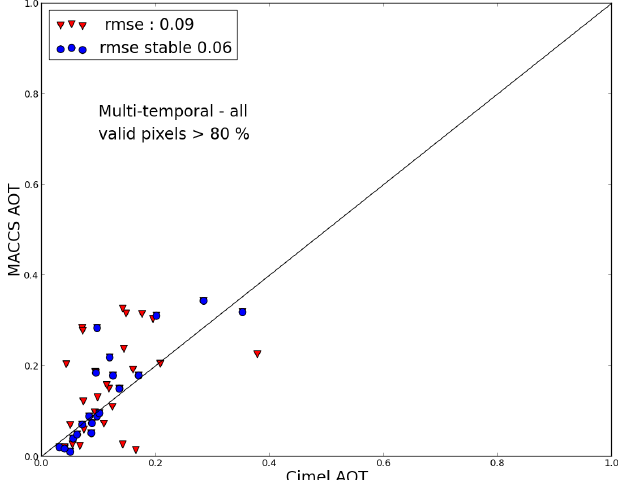
Figure 9. Validation of SPOT-4 (Take 5) AOT estimates with regard to AeroNet in situ measurements over 13 sites in four continents. The blue dots correspond to stable cases, while the red triangles correspond to unstable